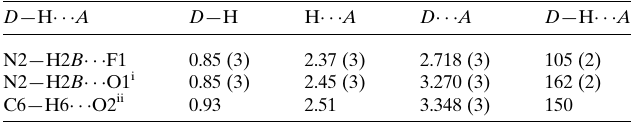
Table 1 Hydrogen-bond geometry (A˚ , (cid:2) ).